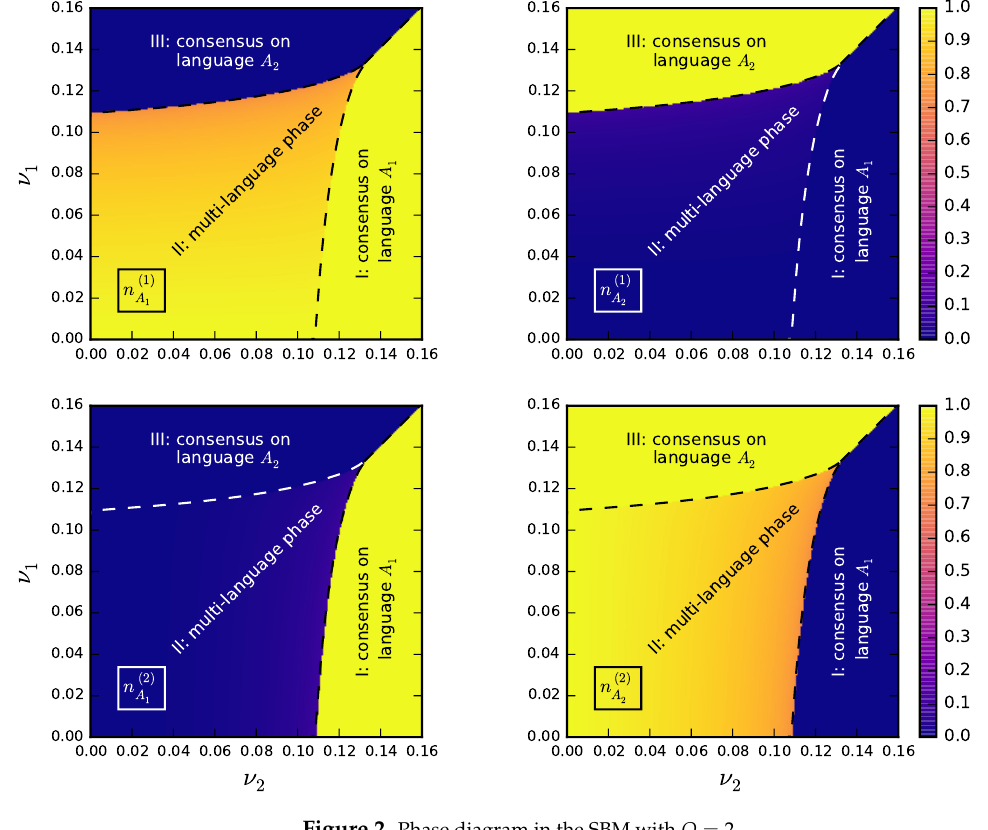
Figure 2. Phase diagram in the SBM with Q =